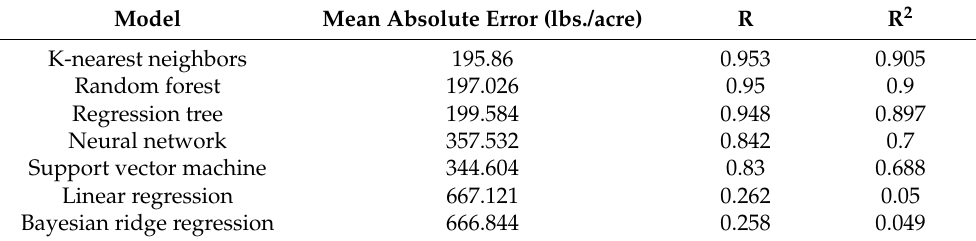
days since the sown date, total rainfall, and the average minimum temperature since the previous